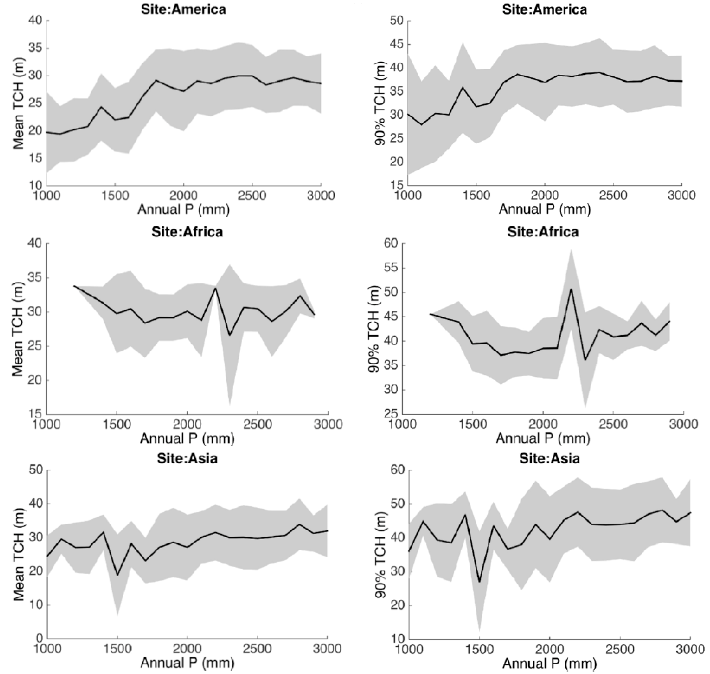
Figure 4. Tree height (TCH m and TCH 90 ) variations with Annual Precipitation. The selection of Annual Precipitation here is shown as an example of height variations with the insignificant variable. The height metrics are binned into up to 20 groups along the Precipitation axis to get the mean and standard deviation.